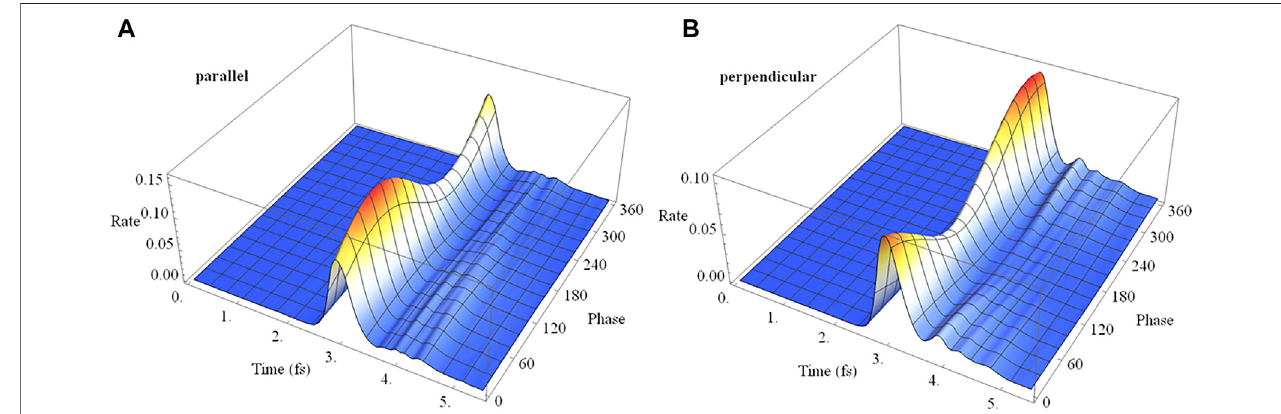
FIGURE11| Ionizationrateasafunctionoftimeandtheinitialphaseofthesuperposition(X+e i ϕ A)fora2cyclelinearlypolarized800 nmpulsewith E max =0.075au for polarizations (A) parallel and (B) perpendicular to the molecular axis.